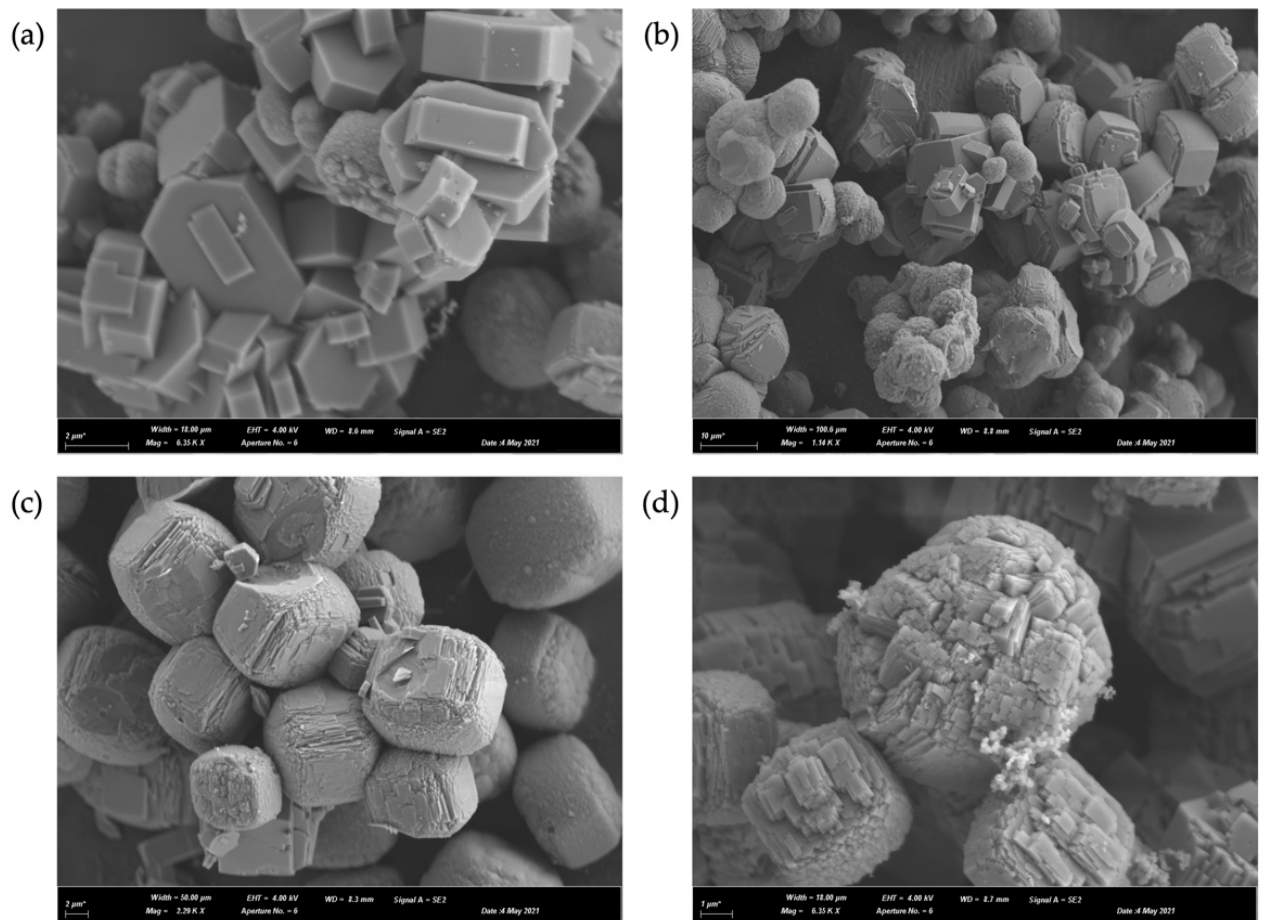
Figure 4. SEM images of 16-ZSM-5 (6350×) ( a ), 16-LZSM-5 (1140×) ( b ), 24-ZSM-5 (2290×) ( c ), and 24- LZSM-5 (6350×) ( d ). 24-LZSM-5 (6350 × ) ( d